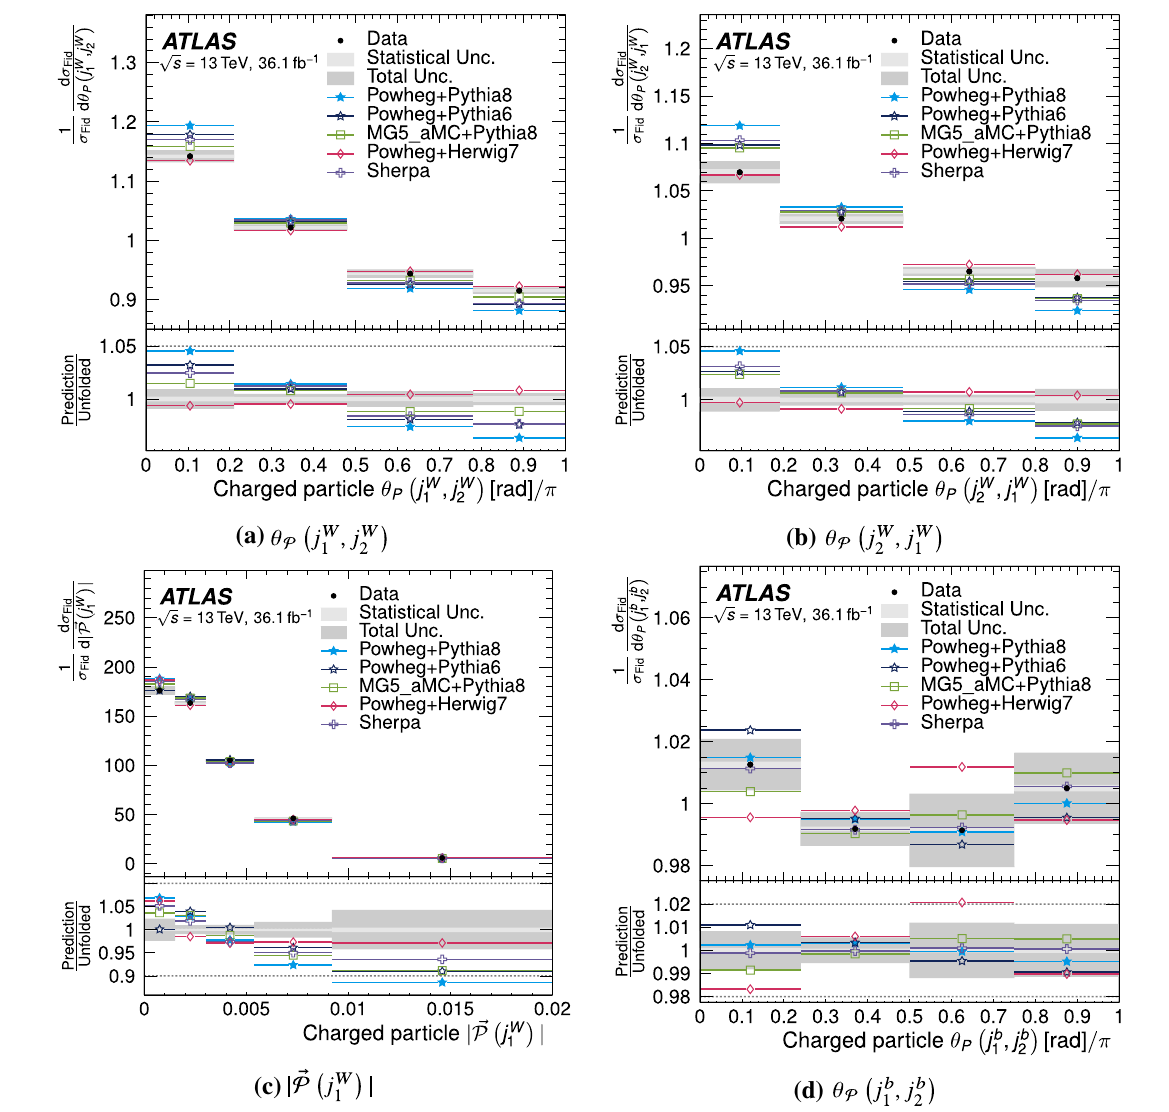
Fig. 5 Normalised fiducial differential cross-sections as a function of the a forward and b backward pull angle for the hadronically decaying W bosondaughters, c themagnitudeoftheleading W daughter’sjet-pull